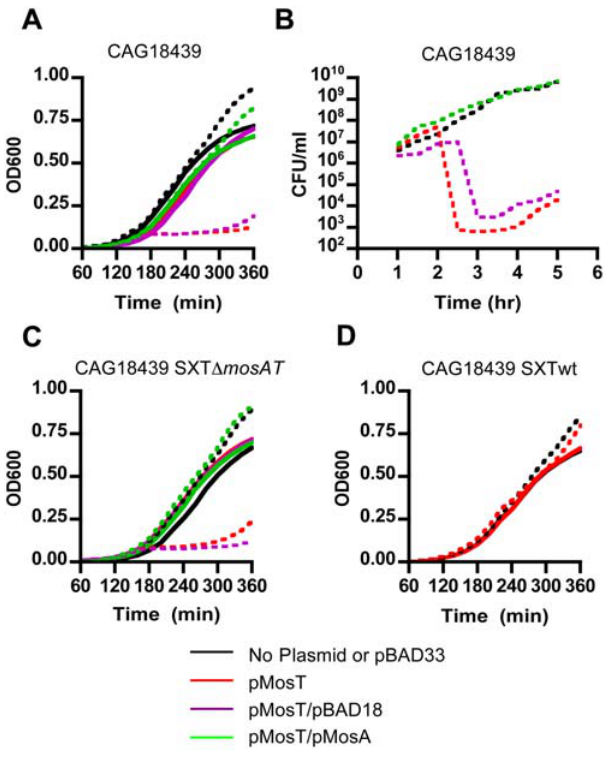
Figure 4. MosT inhibits E.coli growth and its toxicity can be neutralized by MosA. Growth kinetics of E. coli strains CAG18439 (A and B), CAG18439 containing mosAT SXT (C) and CAG18439 containing wild type SXT (D). These strains, which harbored arabinose-inducible mosT and mosA , (pMosT or pMosA respectively) or control vectors, (pBAD33 and pBAD18), were grown in either 0.2% glucose (solid lines) or 0.02% arabinose (dashed lines).